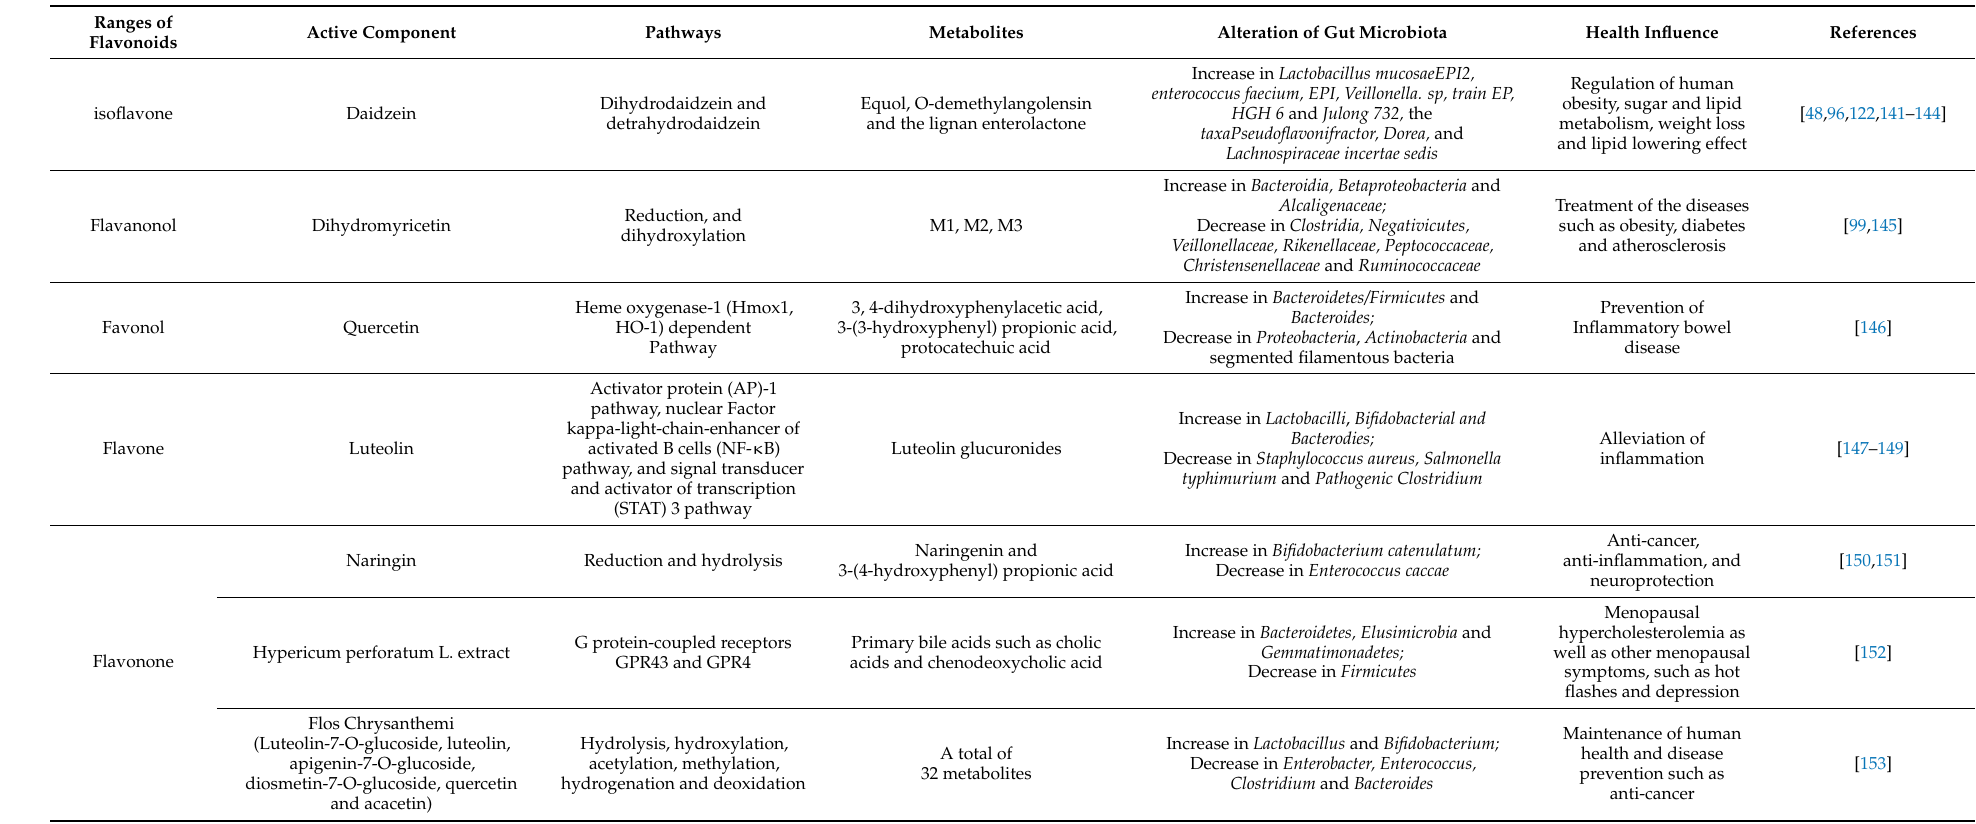
Table 4. Flavonoids regulate gut microbes and their